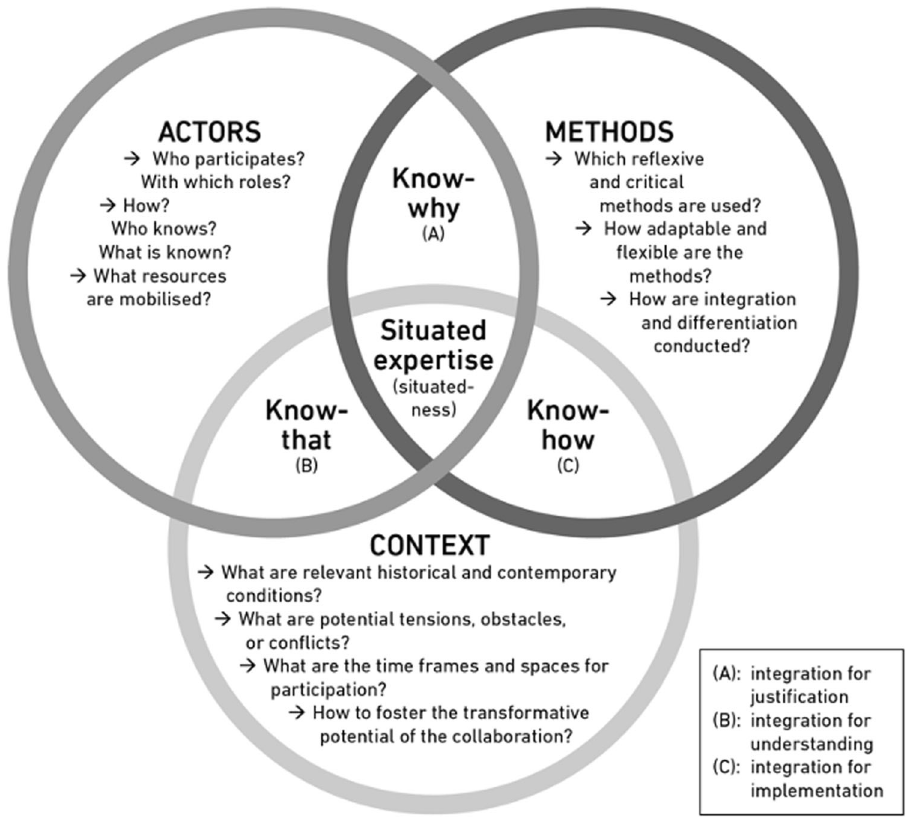
Fig. 1 Heuristic framework for situating expertise in vulnerable contexts. The framework entails three dimensions (context, actors and methods), their categories and three spheres (know-why, know-that; and know-how) together with their three areas of articulation: (A) integration for justi fi cation, (B) integration for understanding; and (C) integration for